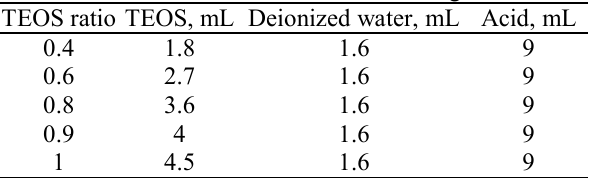
Table 4. Various TEOS molar ratios in sol-gel reaction.